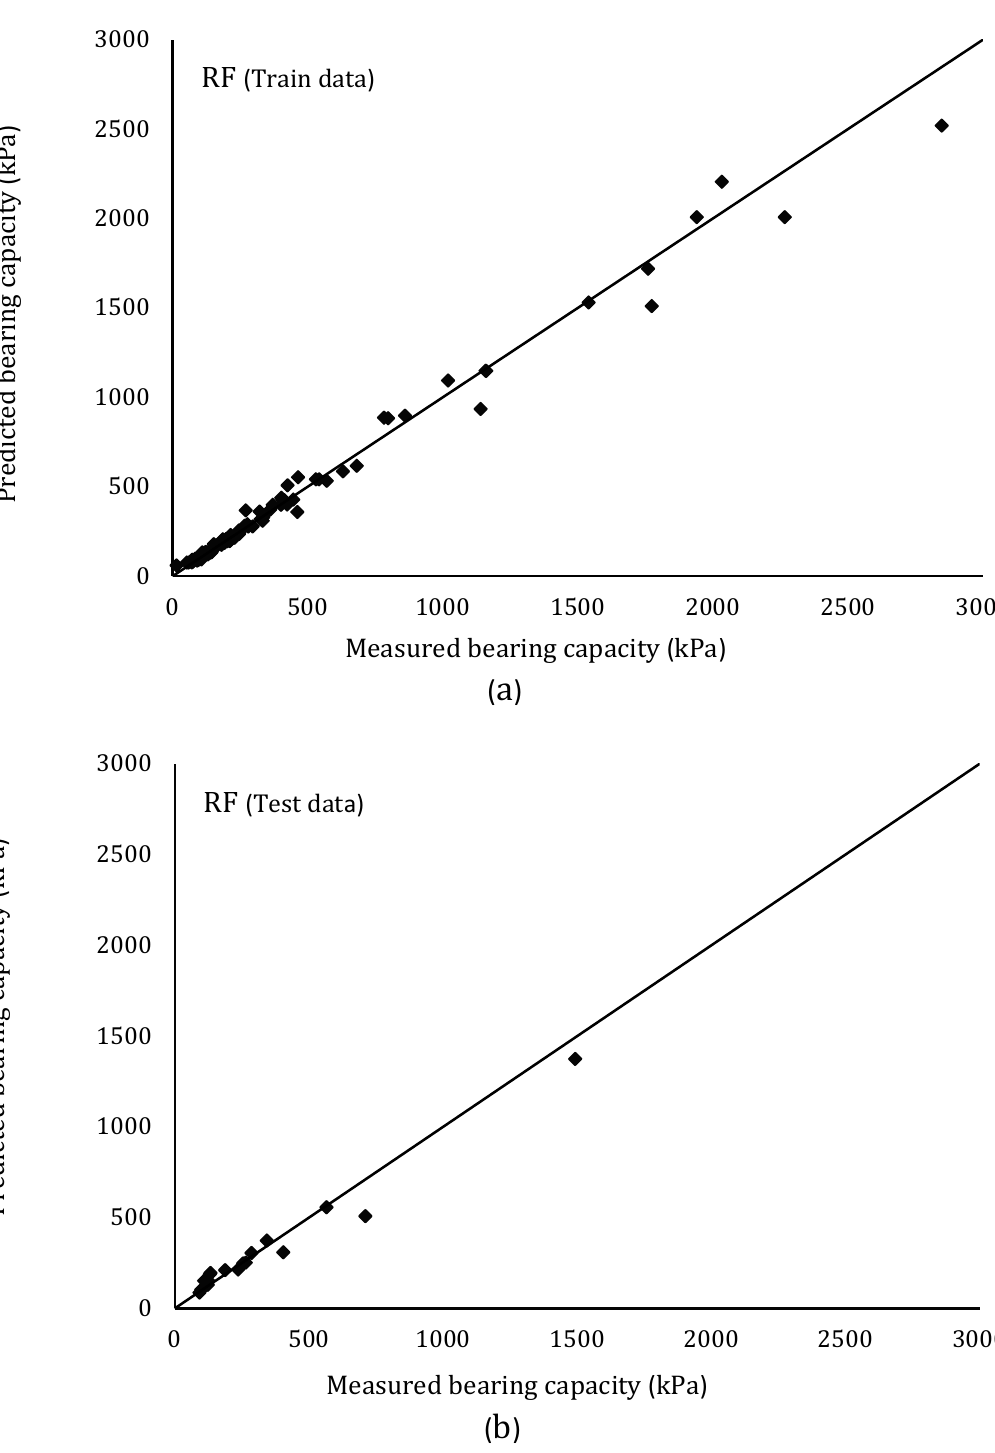
Fig. 4. Measured versus predicted ultimate bearing capacity for RF model, a) training set and b) testing set (solid line indicate best